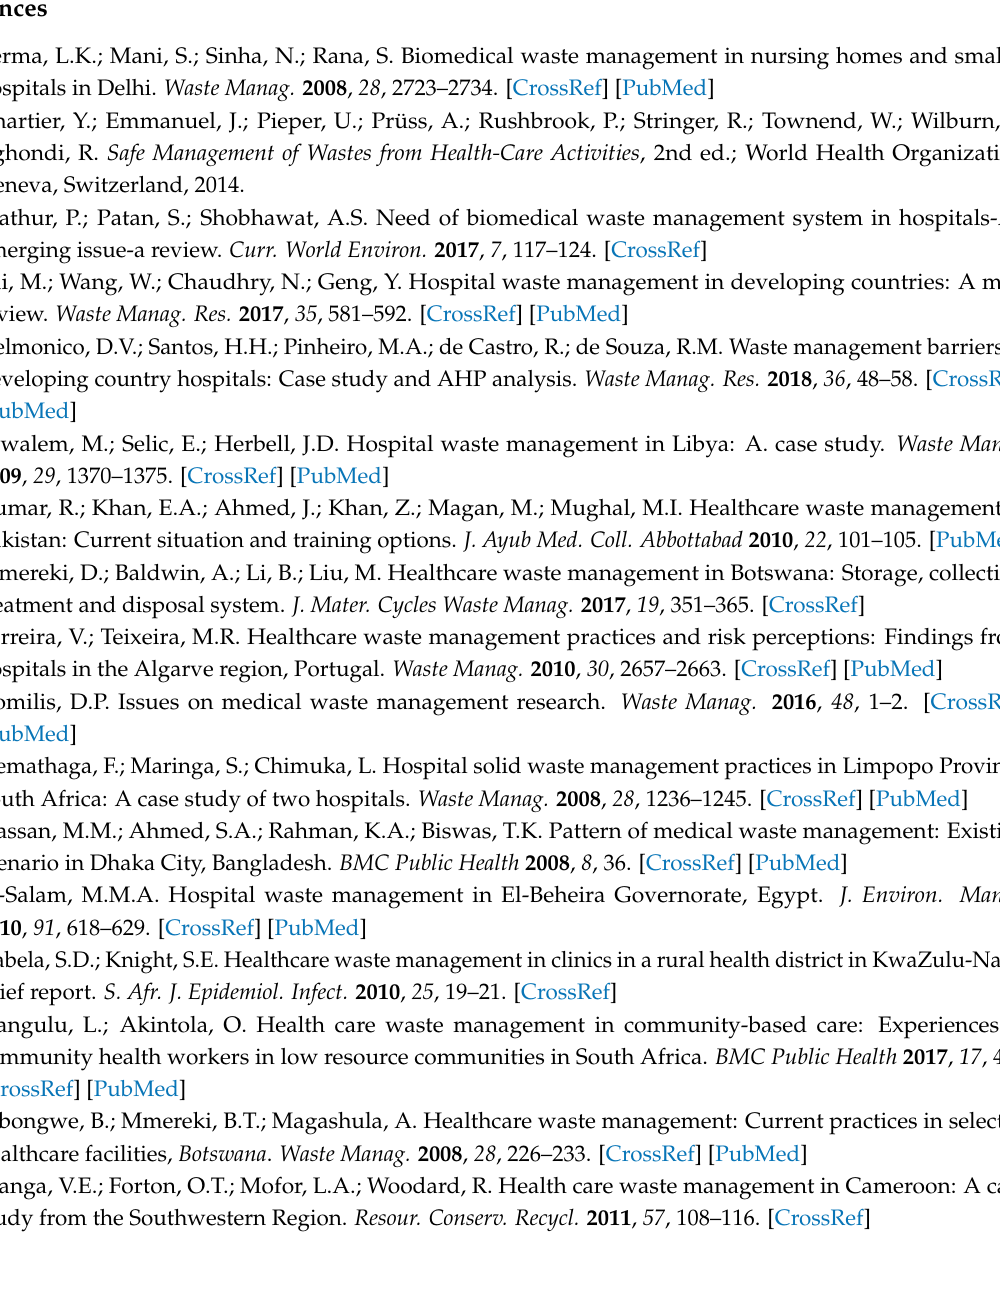
Table S1: Characteristics of newspaper covered in the analysis; Table S2: Table showing databases used in the study; Table S3: A list of all references analysed for the scoping review. Table S4: Coding framework used for the studies included in the scoping